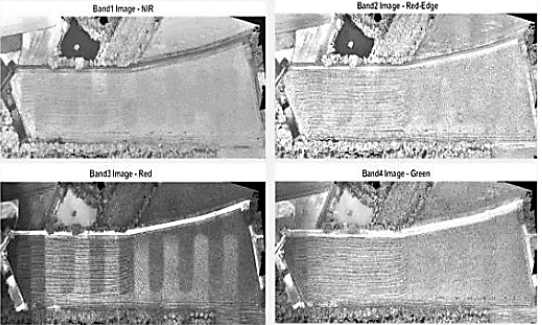
Figure 19. Per band artificial strips corresponding to flight lines Larger overlaps of at least 60% are recommended. However, for UAV-based multispectral image acquisition, Assmann et al., (2019), recommend a minimum of 75% for both front and side